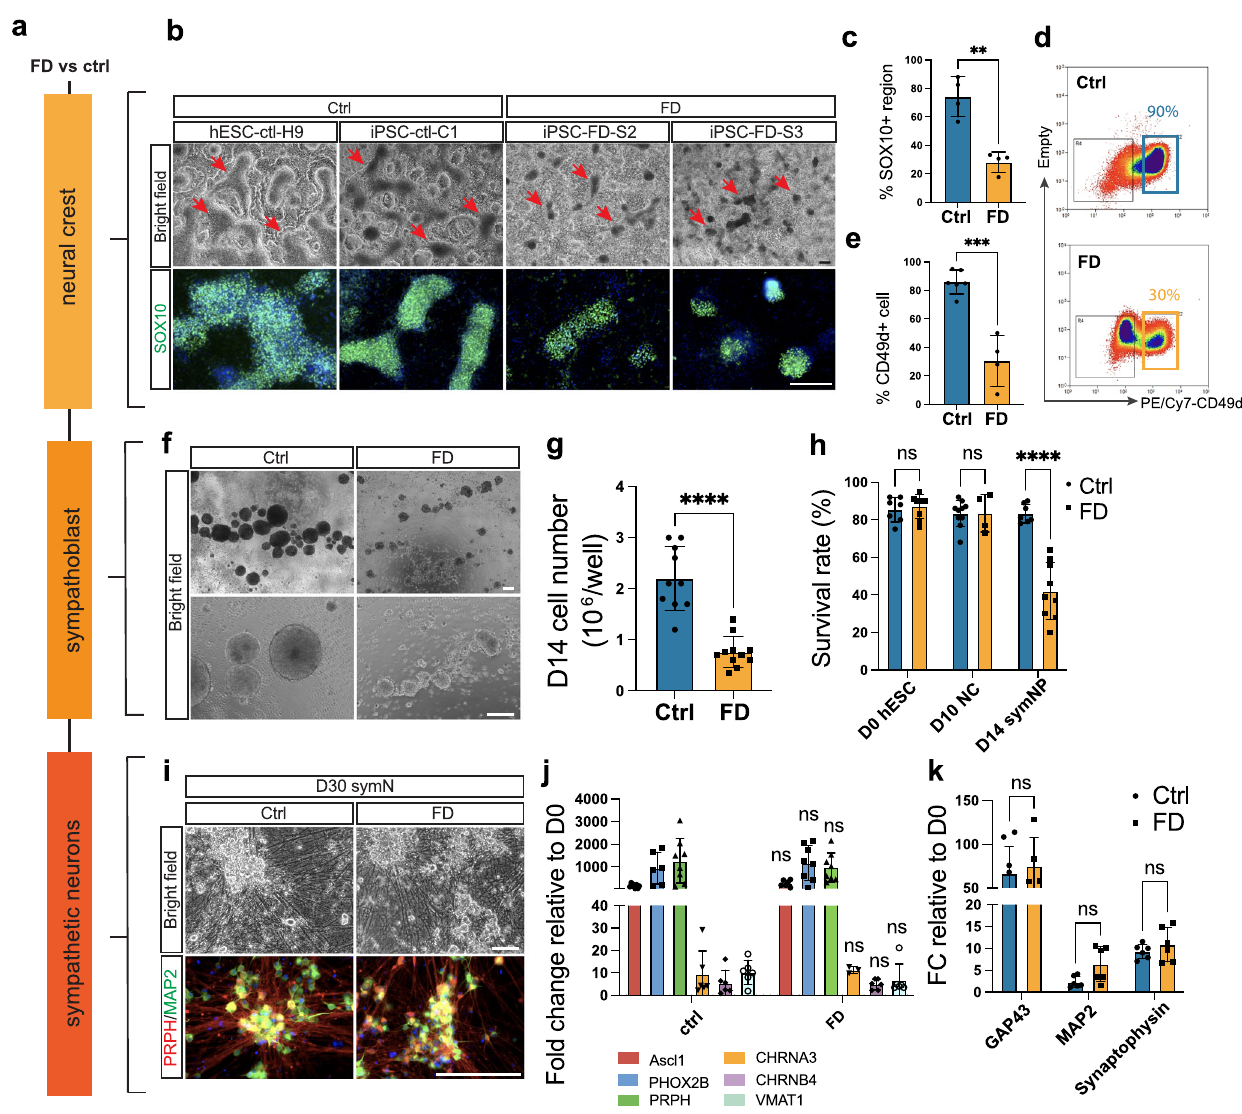
Fig.1|DevelopmentalphenotypesinFamilialDysautonomia(FD)sympathetic neurons (symNs). a Schematic work fl ow of developmental comparisons during symN differentiation in control (ctrl) and FD groups. b Comparison of neural crest cell (NCC) differentiation on day 10. Red arrows indicate the NCC “ ridge ” struc- tures.Immunostaining in bottom row shows SOX10 (green) positive NCCridges at high scale. hESC-ctrl-H9=human embryonic stem cells, WA09, hiPSCs=human induced pluripotent stem cells, C1=healthy ctrl, S2, S3=FD patients. c Quanti fi cation of SOX10 + cell area in ( b ). n =4 biological replicates. Two-tailed Student ’ s t-test. Error bar represents the SEM. ** p <0.01. d Day 10 NCC number is analyzed by FACSusing PE/Cy7-CD49d.Bluerectangleinctrland yellow in FD gate CD49d + fractions. e Quanti fi cationofCD49d + cellnumber by FACS. N =(ctrl: 6, FD: 4) biological replicates. Two-tailed Student ’ s t-test. Error bar represents the SEM. *** p <0.001. f Representative sympathoblast spheroids are compared on day14. g Day 14 total cell numbers after dissociation is compared. N =(ctrl: 10, FD: 11) biological replicates. Two-tailed Student ’ s t-test. Error bar represents the SEM. **** p <0.0001. h Survival rates after dissociation are quanti fi ed and compared at